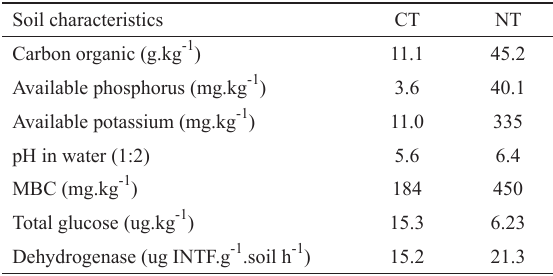
Some background soil